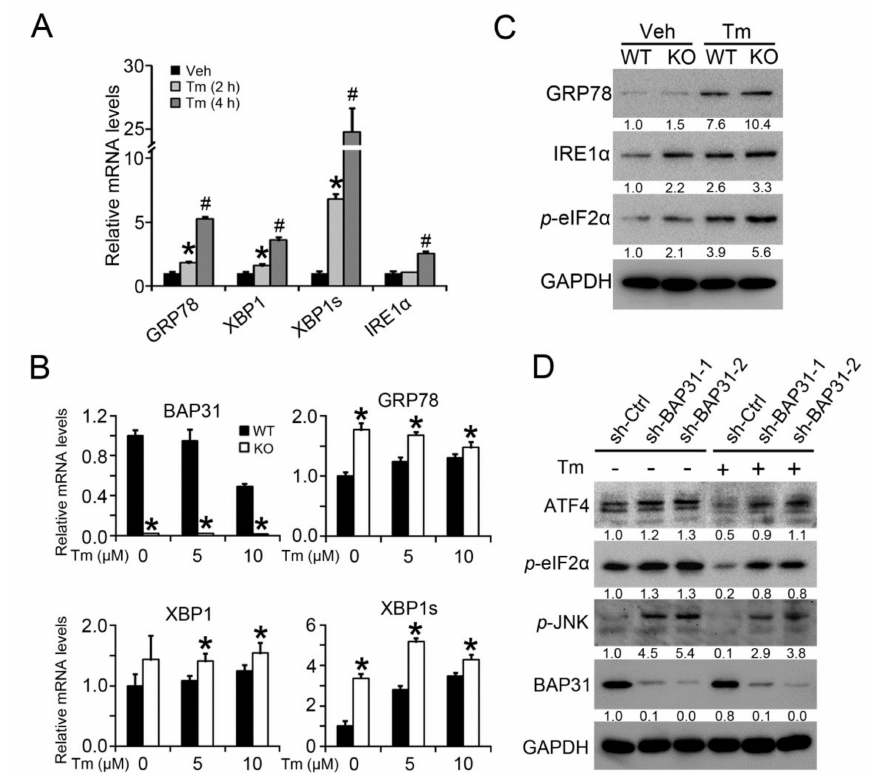
Figure 7. BAP31 deficiency induced ER stress in vitro. Primary hepatocytes were isolated from male WT and KO mice. ( A ) 24 h after the attachment, cells were treated with Tunicamycin (5 µ M) for 2 or 4 h, the mRNA levels of GRP78 , XBP1 , XBP1s and IRE1 α were determined. Data represent as mean ± SEM. *, p < 0.05, Tm (2 h) compared with Veh. #, p < 0.05, Tm (4 h) compared with Veh. ( B ) Primary hepatocytes were treated with Tunicamycin (5 and 10 µ M) for 4 h, the mRNA levels of BAP31 , GRP78 , XBP1 and XBP1s were determined. Data represent as mean ± SEM. *, p < 0.05, KO hepatocytes compared with WT. ( C ) Primary hepatocytes were treated with Tunicamycin (5 µ M) for 12 h. The protein levels of GRP78, IRE1 α , p -eIF2 α were determined. ( D ) HepG2 cells with targeted p -eIF2 α , p -JNK and BAP31 were determined. GAPDH was used as a loading control. All